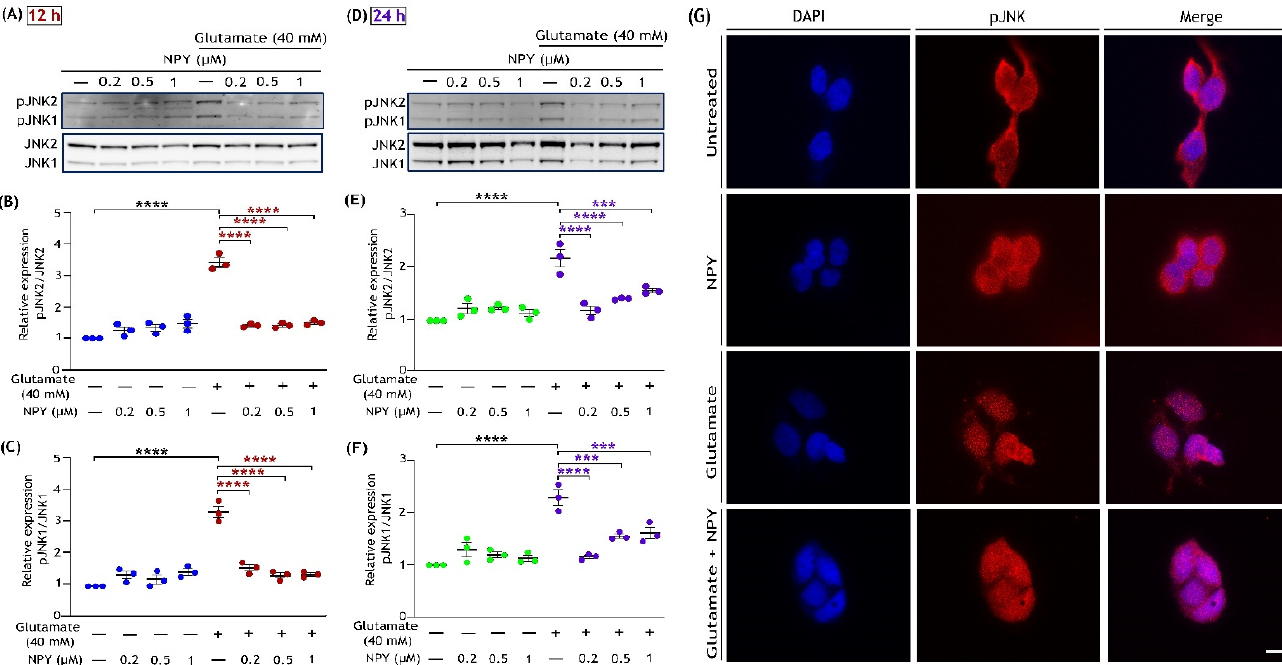
Figure 3. NPY treatment suppresses the activation of pro-apoptotic JNK induced by glutamate in SH-SY5Y cell cultures. Western blot analysis illustrates the glutamate induced phosphorylation of JNK (T183/Y185), while NPY treatments (glutamate + NPY) reduced the phosphorylation of JNK at 12 h ( A ) and densitometric quantification of JNK2 ( B ) and JNK1 ( C ) phosphorylation indicates a significant increase in phosphorylation of JNK induced by glutamate compared to control (F(1,16)= 102 in Figure ( B ) and F(1,16)= 67.85 in Figure ( C ), **** p < 0.0001, n = 3) and a concentration-dependent decrease with NPY treatments at 12 h (F(3,16) = 34.88 in Figure ( B ) and F(3,16) = 25.90 in Figure ( C ), **** p < 0.0001 represents significance between glutamate and glutamate + NPY group (red), n = 3). Western immunoblot analysis for 24 h treatment ( D ) and their densitometric quantification of JNK2 ( E ) and JNK1 ( F ) phosphorylation levels indicates a significant increase in phosphorylation of JNK induced by glutamate compared to control (F(1,16)= 59.13 in Figure ( E ) and F(1,16)= 64.77 in Figure ( F ), **** p < 0.0001, n = 3) and a concentration dependent decrease with NPY treatments (F(3,16) = 7.82 in Figure ( E ) and F(3,16) = 7.926 in Figure ( F ), *** p < 0.001 and **** p < 0.0001 represents significance between glutamate and glutamate + NPY group (purple), n = 3). ( G ) Immunofluorescence images (representative) of treated SH-SY5Y cells showing the expression of phosphorylated JNKs. After 12 h of treatment, cells were fixed and immunostained with an anti-phospho-JNK (T183/Y185) antibody (red). Nuclei were stained with DAPI (blue). Scale bar = 10 µ